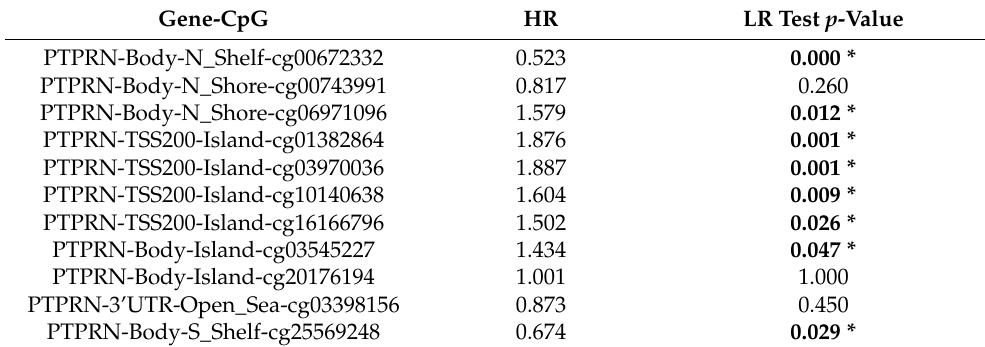
Table 2. Prognostic Value of Single CpG of the PTPRN gene family in LGG by MethSurv platform. Gene-CpG HR LR Test p -Value